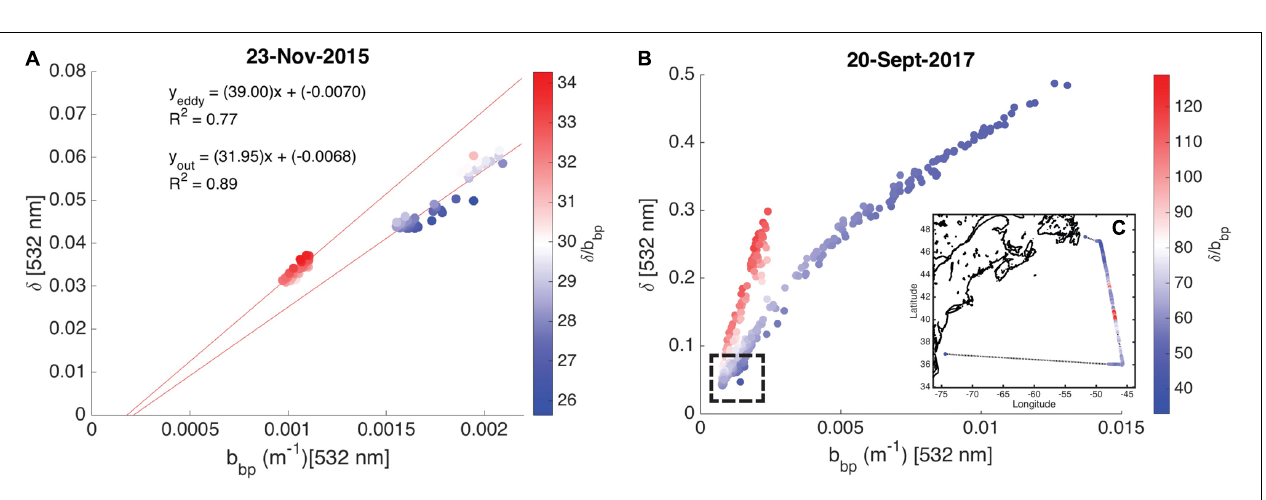
Frontiers in Marine Science |